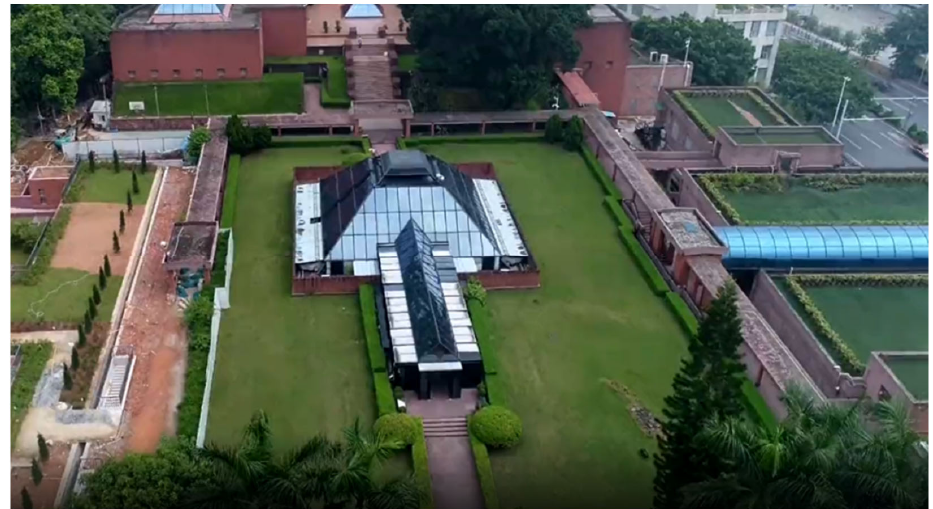
Figure 16. The tomb of the Western Han Dynasty in the city has been converted into a museum [37].